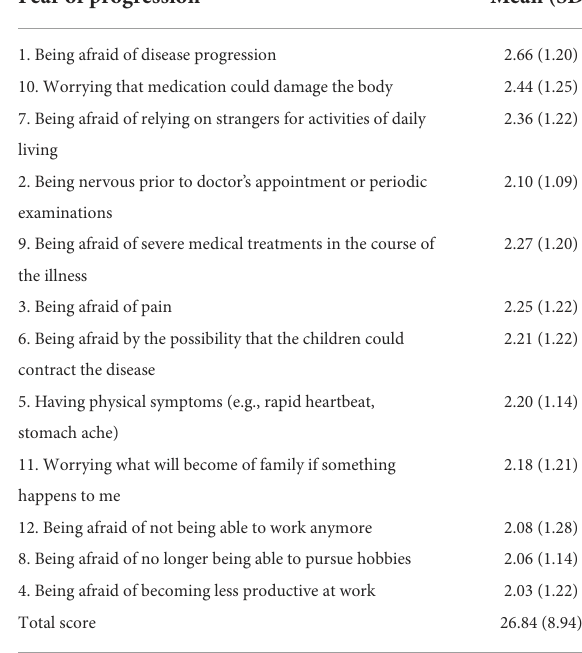
TABLE 2 Fear of progression in the type 2 diabetic patients ( n = 385).